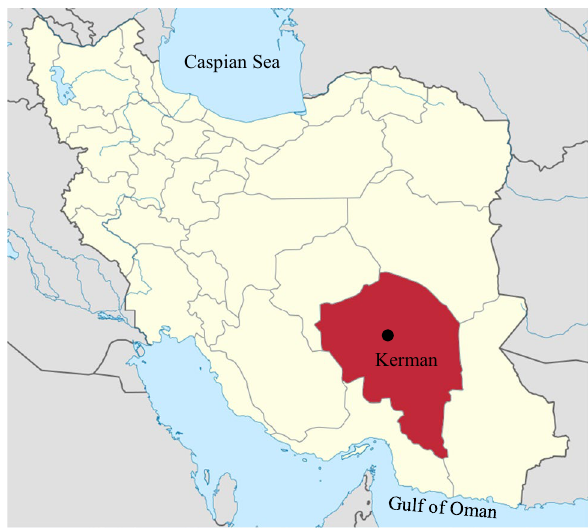
Fig. 1 The location of Kerman province in Iran